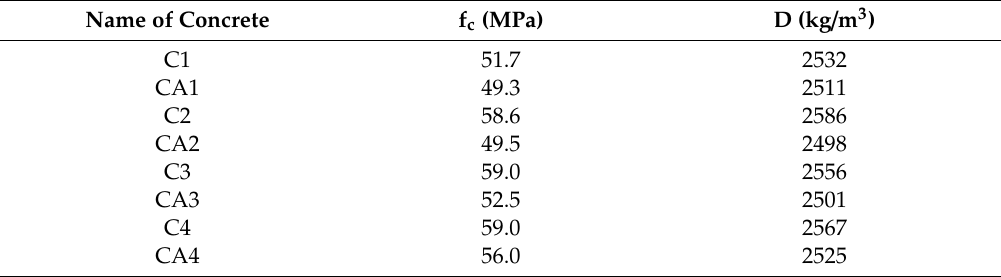
Table 5. Results of the compressive strength and density tests.